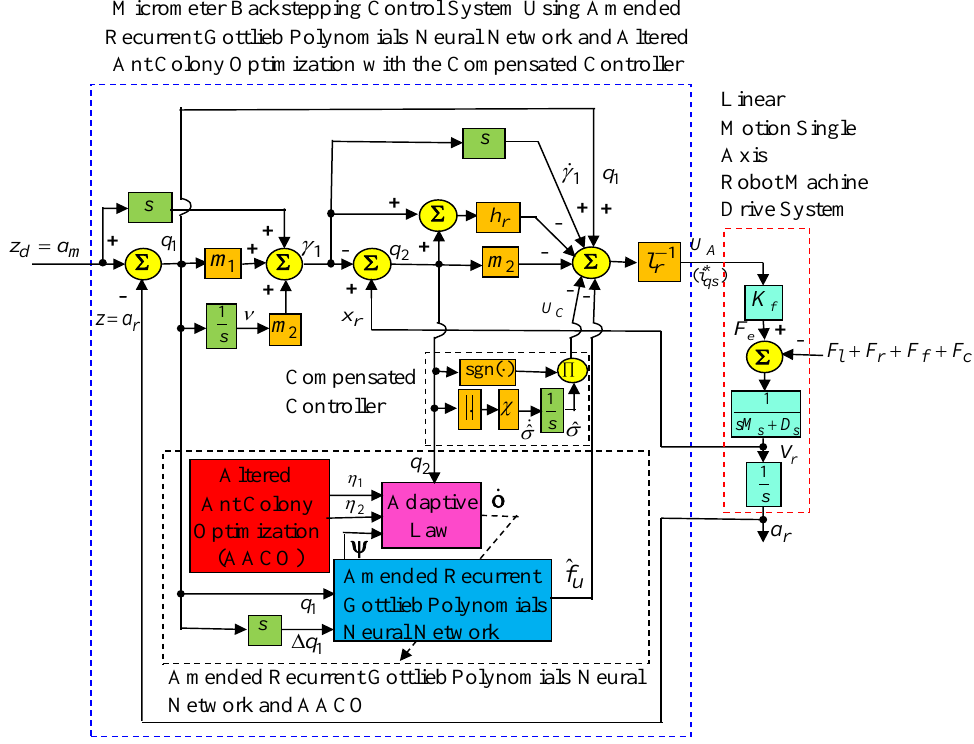
Figure 3. Micrometer backstepping control system using an amended recurrent Gottlieb polynomials neural network and altered ant colony optimization with the compensated controller.